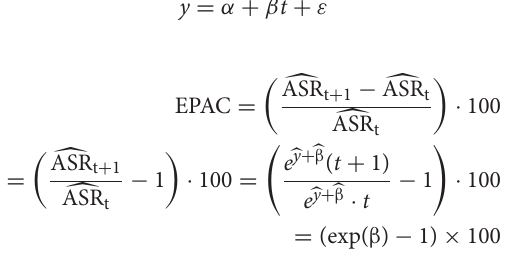
( Supplementary Table 5 , Supplementary Figure 2A ). During